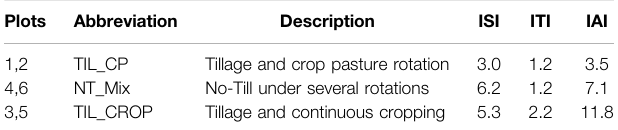
TABLE 3 | Treatment groups according to their multiplier IAI criteria based on the summed experimental period averages of the index of sequence intensi fi cation (ISI) and the index of tillage intensi fi cation (ITI).